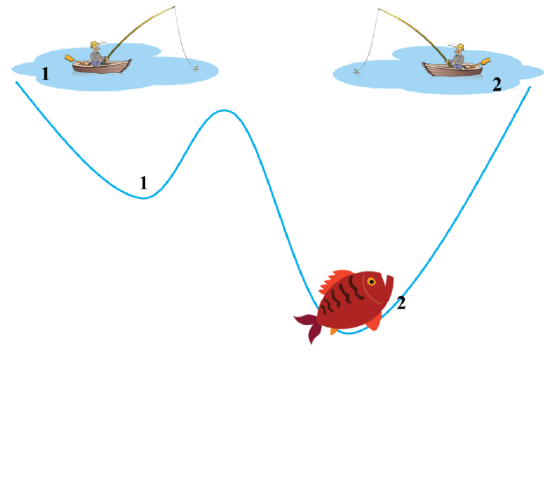
Figure 6: Basic cncept of PSO